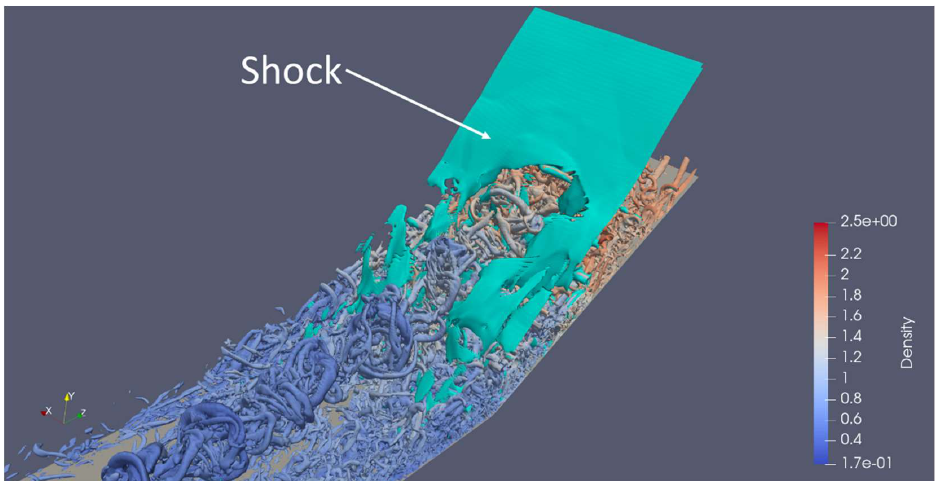
Figure 5. Vortex rings interact with shock waves.